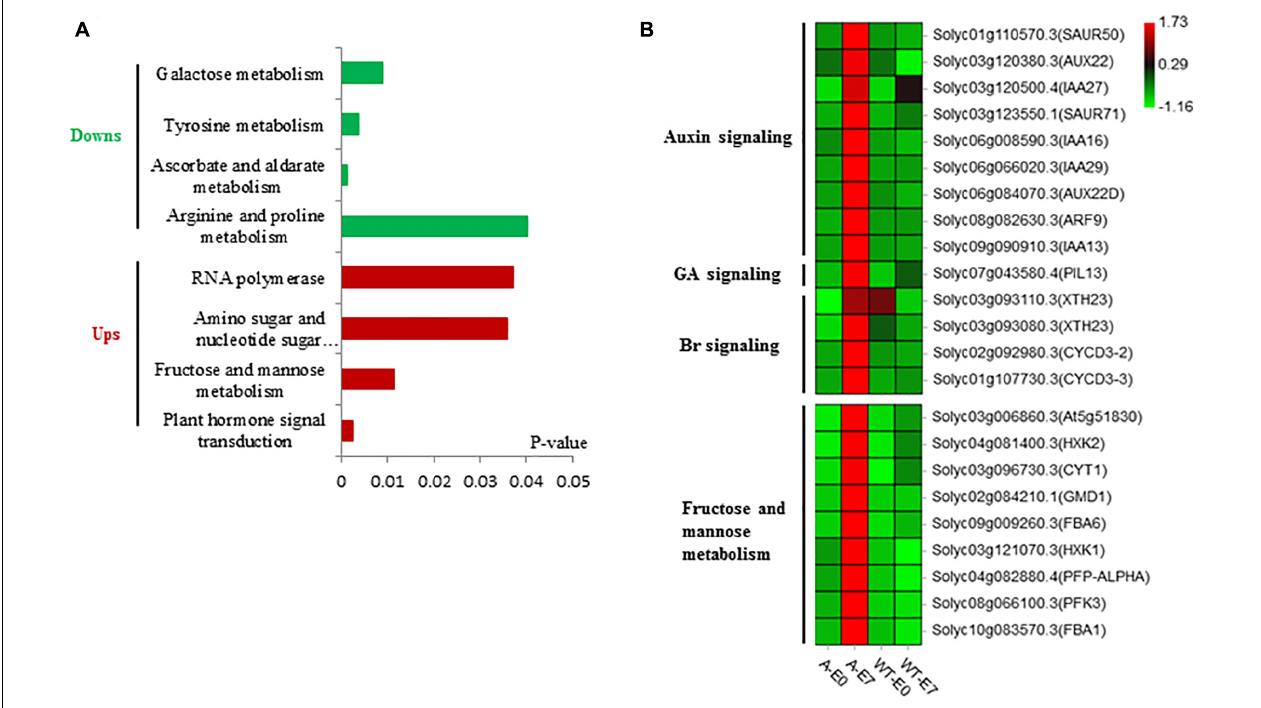
FIGURE 6 | Functional analysis of DEGs specifically expressed in SlTPL1RNAi tomato ovaries. (A) Enriched gene sets of specifically up-regulated and down-regulated expressed genes in SlTPL1-RNAi plants during fruit set process as per PlantGSEA (B) heatmap of DEGs in gene sets of plant hormone signaling transduction and gene sets of fructose and mannose metabolism.